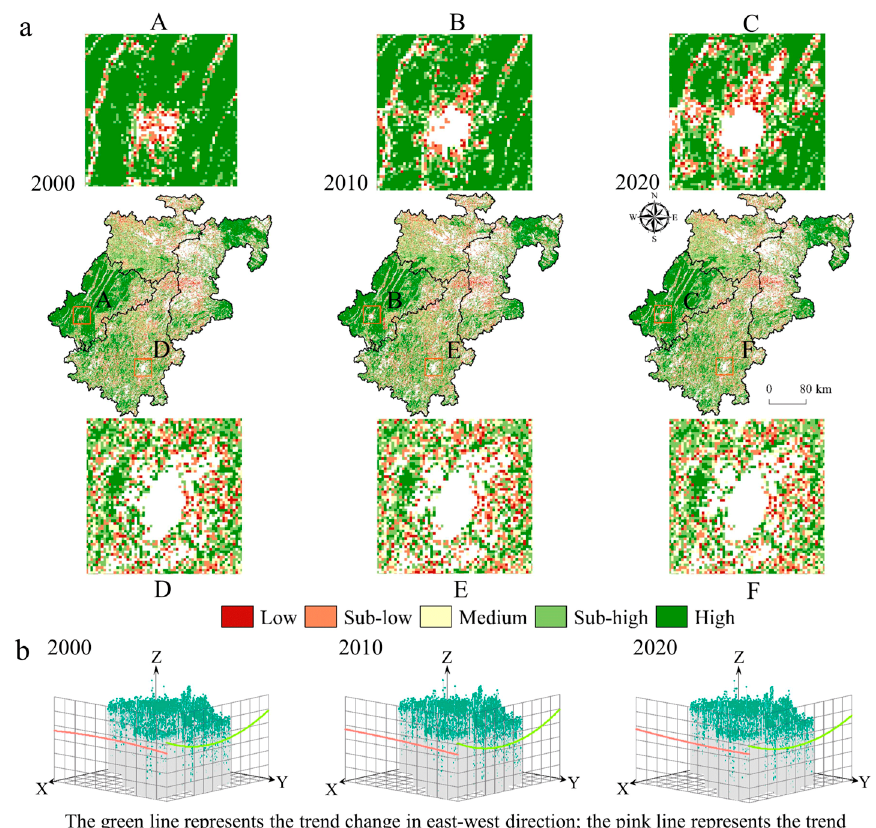
Figure 3. Spatial and temporal distribution of the CLES in karst trough valley areas: ( a ) spatial and temporal distribution characteristics; ( b ) trend analysis.